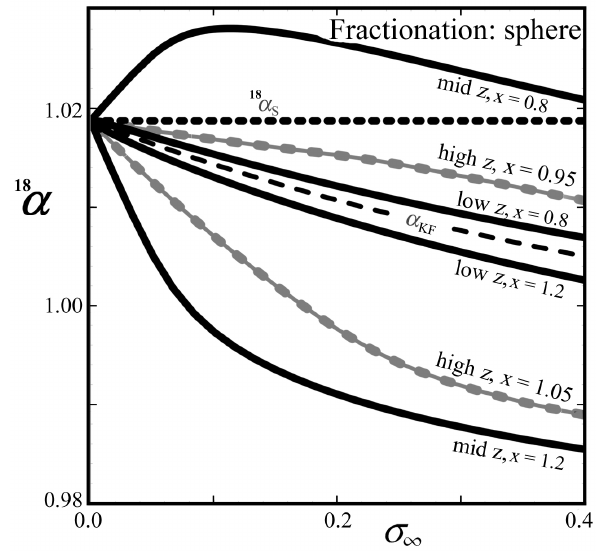
Fig. 2. Calculated H 18 O fractionation coefficients 18 α for com- 2 pletely facetted ice growing from the vapor at − 20 ◦ C, a fixed crys- tal size, and a range of supersaturations σ ∞ . Dotted and dashed lines show equilibrium and KF fractionation values. Deviations from the KF prediction depend on x = β / i β , which is assumed con- stant, and z = Z S / Z V , which decreases with increasing σ ∞ . Light, beaded curves have the highest z values considered here, exceed- ing 3.1 at all σ ∞ ( Z V = 100, σ 1 = 0 . 5, n = 10). The two “low z ” curves have z values below 0.1 when σ ∞ ≥ 0 . 05 ( Z V = 1000, σ 1 = 0 . 2, n = 1). The uppermost and lowermost curves have mid- dling z values, exceeding 1 when σ ∞ ≤ 0 . 2 ( Z V = 1000, σ 1 = 0 . 4 , n =